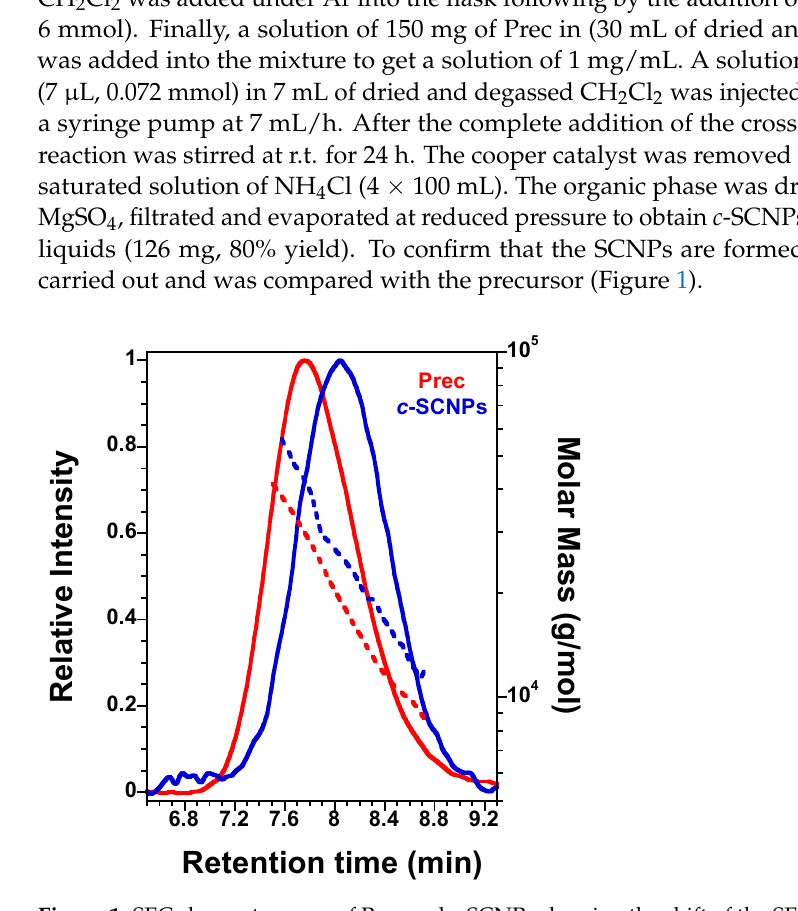
Figure 1. SEC chromatograms of Prec and c -SCNPs showing the shift of the SEC retention peak (solid lines) and molar mass of Prec upon chain compaction via “click” chemistry to produce c -SCNPs (dashed lines).